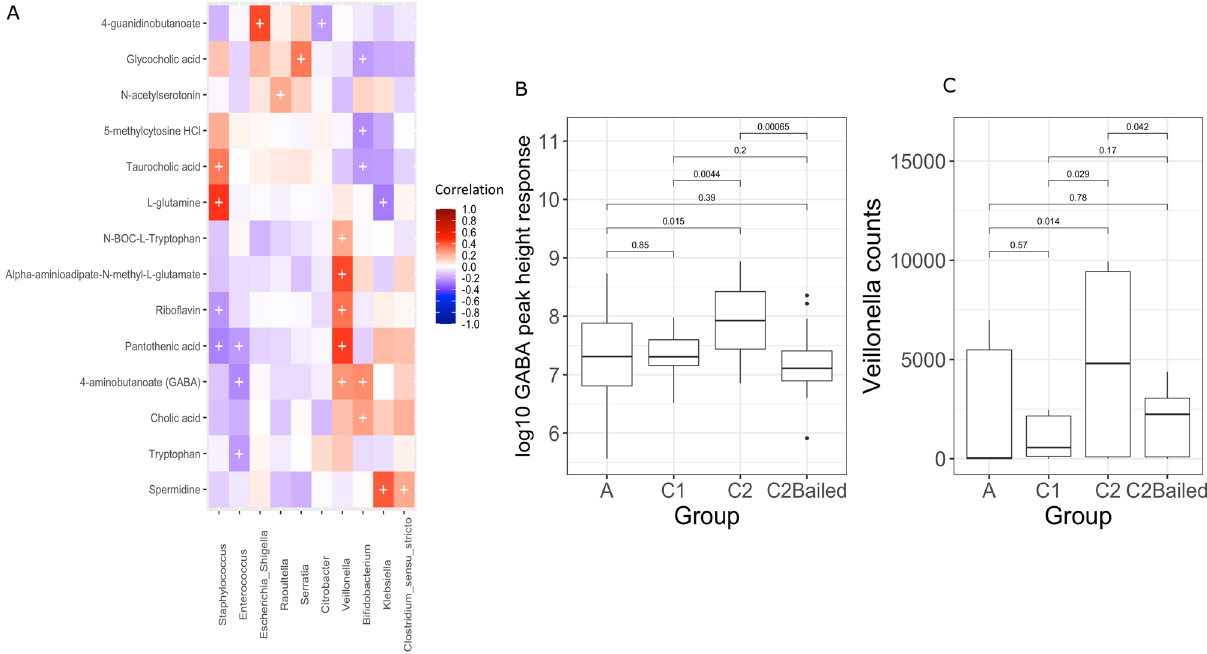
Figure 6. Metabolites in stool correlate with abundance of bacterial genera. ( A ) Heatmap of repeated measures correlation coefficients between peak response heights of identified metabolites in stool and the top 10 bacterial genera from the same samples (n = 90 stool samples). Significant correlations are indicated by a ‘ + ’ with FDR- corrected p values < 0.05. ( B ) Boxplot comparing the peak response heights for 4-aminobutyric acid (GABA) between enrollment groups. Statistical comparisons were made using the Wilcoxon test. ( C ) Boxplot comparing the number of rarefied Veillonella counts between the enrollment groups. Statistical comparisons were made using the Wilcoxon test. A summary of the number of infants and samples by group for metabolomics is given in Table